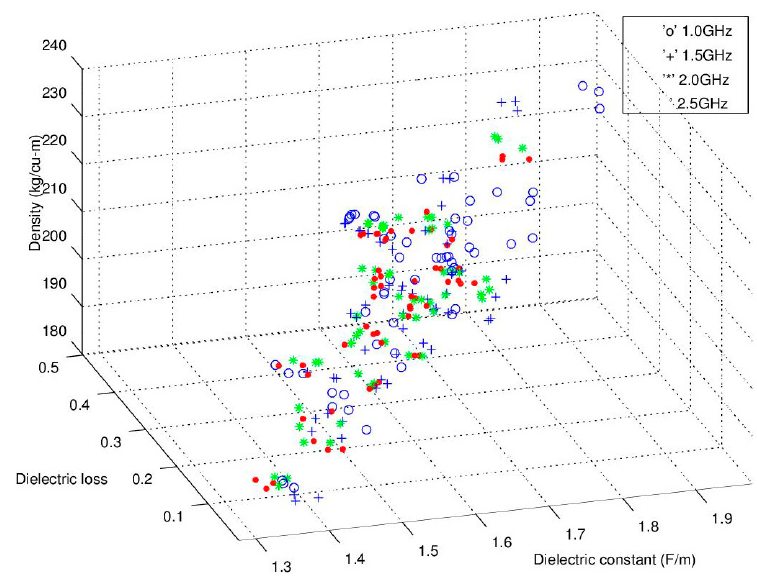
Figure 8. Cole-Cole plot of the response for the measured frequencies (1.0, 1.5, 2.0 and 2.5 GHz) with density shown on the z -axis.